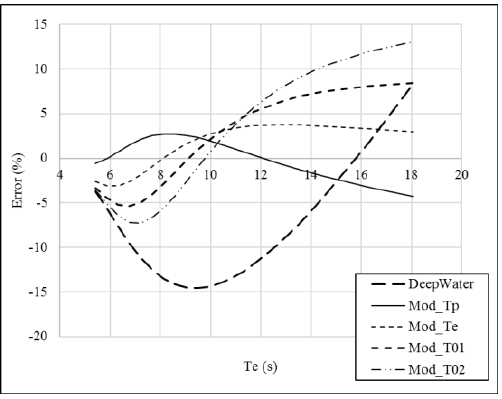
Figure 15. Errors for deep-water formulas and modifications using different periods ( h = 25 m).